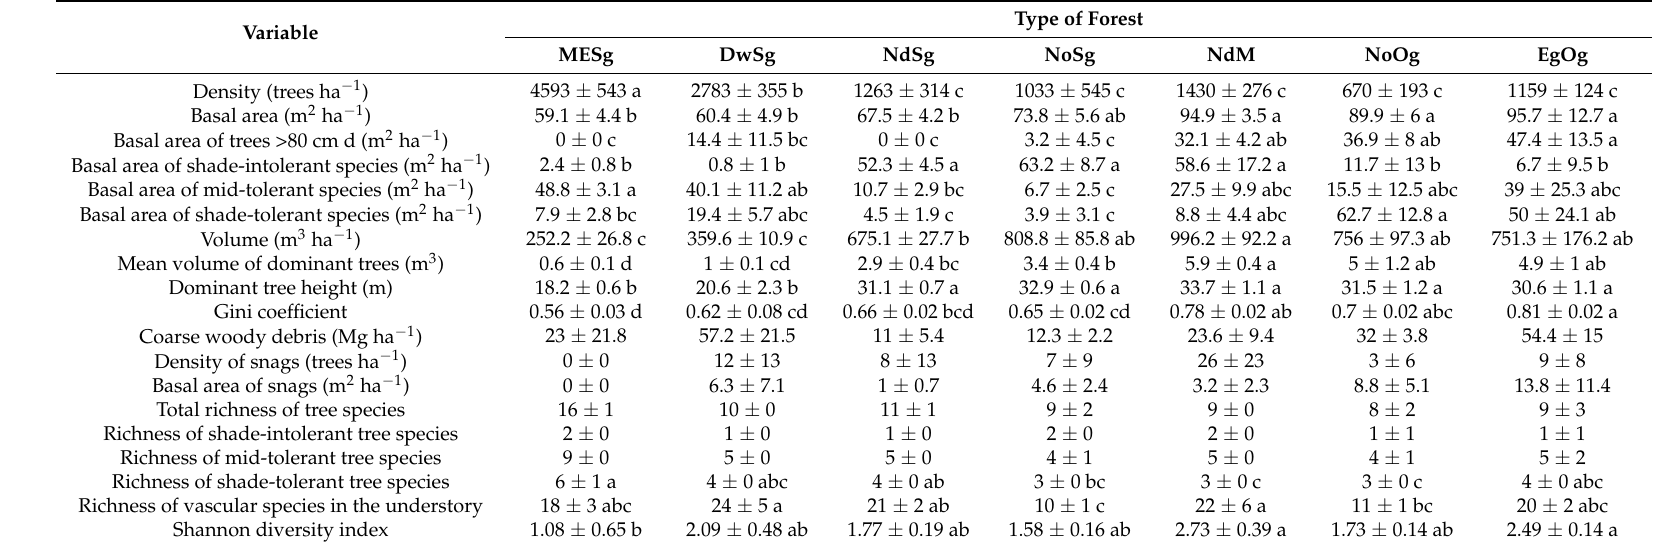
Table 3. Comparison of variables tested in second- and old-growth forests (average ± sd). Different letters within each row represent significant differences ( p -value < 0.05). Density, basal area of trees >80 cm d and the Shannon diversity index were compared with